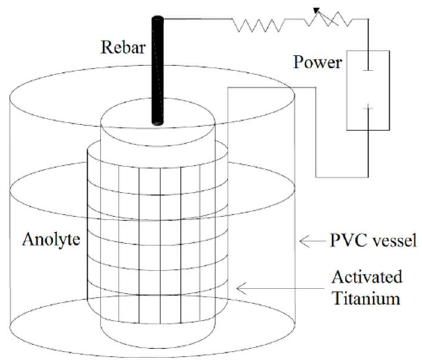
Figure 1. Schematic illustration of the ECE.